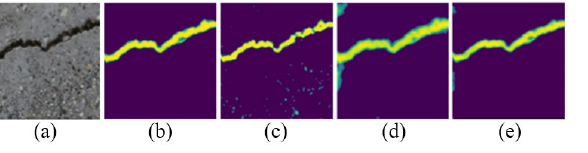
Figure 4. The results of different models for obvious cracks: (a) original image, (b) Baseline U-Net, (c) VGG16 + BCE Loss, (d) VGG16 + Focal Loss, and (e) VGG16 + Focal Loss with more training datasets.